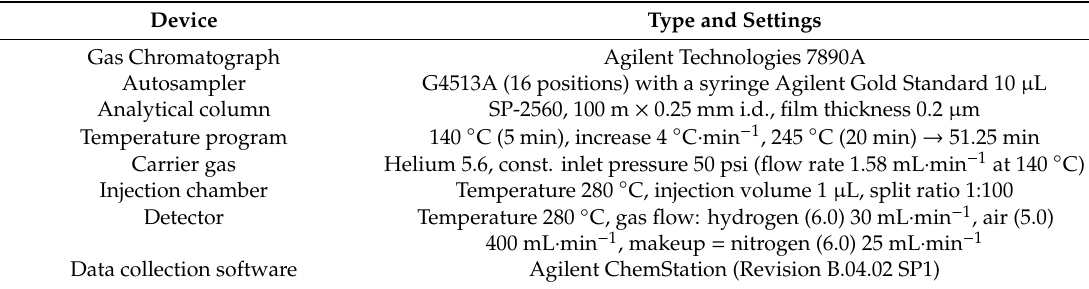
Table 2. Device parameters and GC analysis